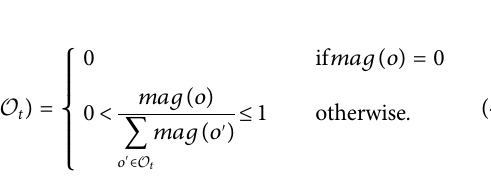
FIGURE 5 | In MindTrails, red tokens are more important than non-reds. While a traditional GR system (left) , as before, records everything, a magnitude-aware system gives greater weight to reds, only resorting to random selection — or potentially forgetting precise locations — when magnitudes are the same. Here, after the fi rst turn, only the reds adjacent to A4 and A5 are stored at full magnitude/clearly